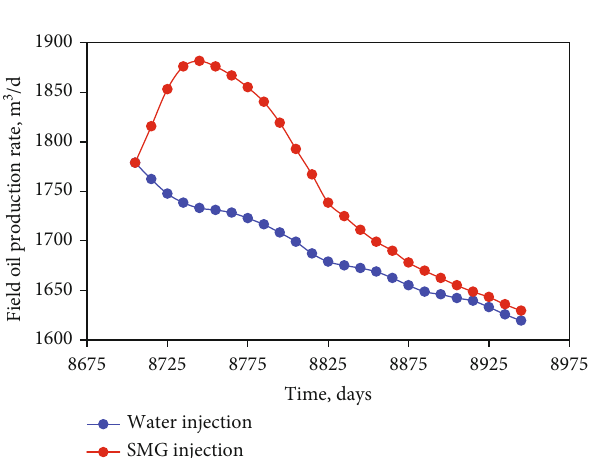
Figure 17: Change in daily oil production after microgel